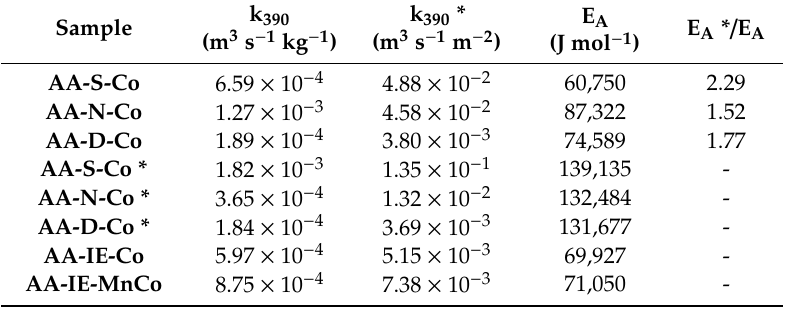
Table 5. Kinetic parameters for N 2 O decomposition over cobalt based catalysts in the pellet and crushed